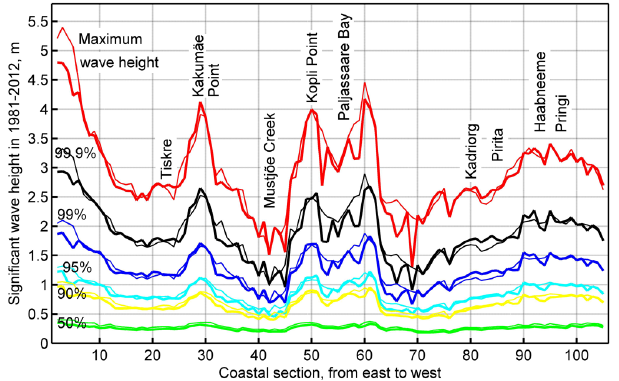
Fig. 3. Maximum wave heights, higher quantiles and median wave height in the nearshore of the study area in 1981–2012. Thin lines indicate the modelled wave heights, and bold lines show values for the breaking-wave heights calculated from Eq. (4). Geographical locations and the position of the coastal sections are indicated in Fig. 2.